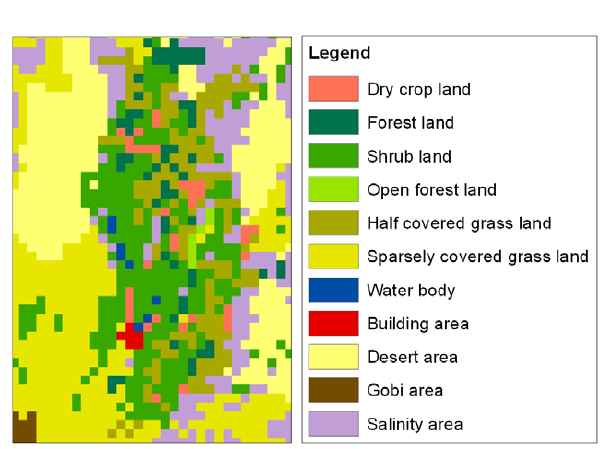
Fig. 2. Land cover map of the Ejina Oasis in 2004 (data provided by the Environmental and Ecological Science Data Center for West China, National Natural Science Foundation of China (http://westdc.westgis.ac.cn).